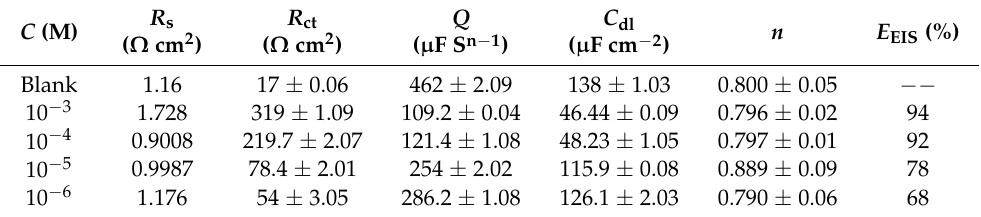
Table 3. Impedance parameters for MS/ HCl system without and with different PPD